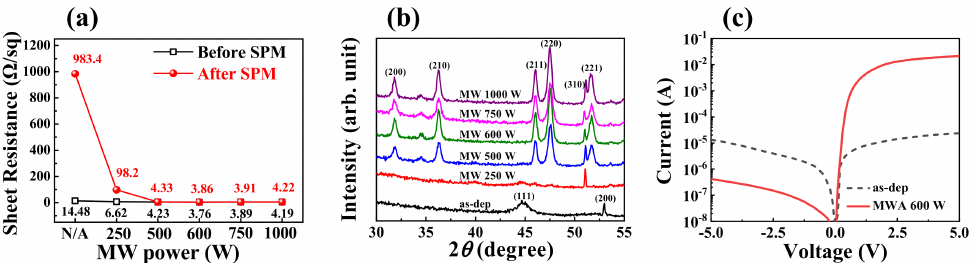
Figure 3. ( a ) Sheet resistance (Rs) and ( b ) XRD patterns of the microwave-assisted Ni-silicides formed under various MWI powers. ( c ) The characterization of Schottky contact of